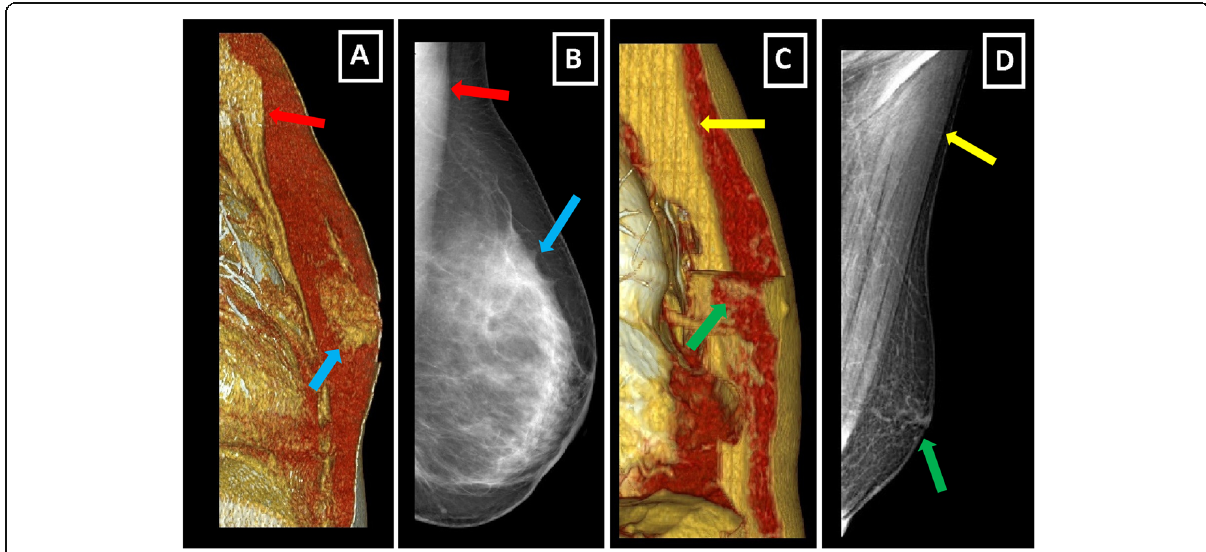
Fig. 1 Differences between female and male breast. a , b Oblique sagittal VRT image and MLO mammography image of normal female breast. Note the well-developed fibroglandular structures (blue arrows) and smaller pectoral muscles (red arrows). c , d Oblique sagittal VRT image and MLO mammography image of normal male breast. Note the rudimentary structure of male breast with involuted fibroglandular tissue, small nipple-areolar complex (green arrows), and prominent pectoral muscles (yellow